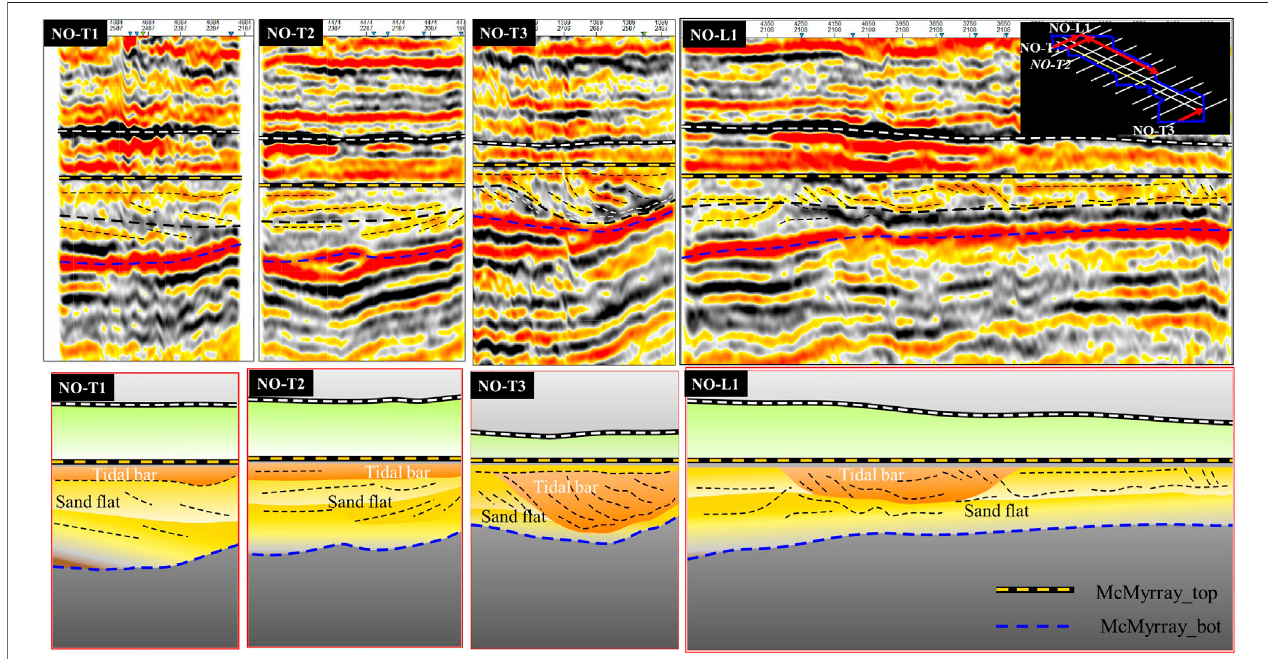
FIGURE 8 | The superposition patterns between tidal bar and sand fl at. The superposition patterns are based on pro fi les of seismic interpretations.